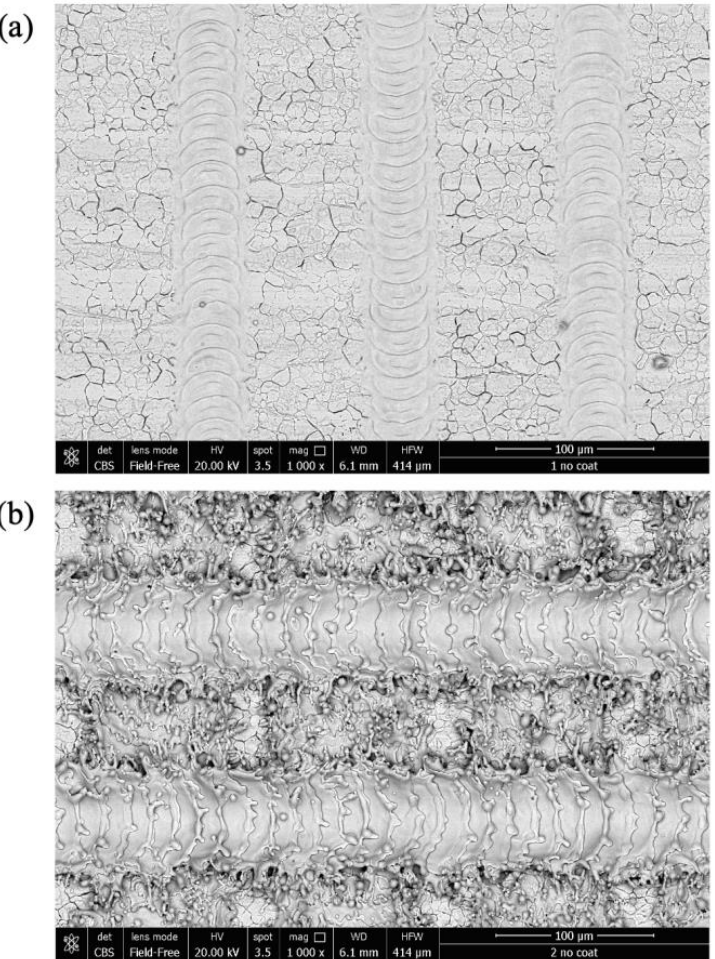
Figure 7. SEM images of laser-textured surfaces without coating obtained with parallel lines scanning strategy: ( a ) 2 W; ( b ) 7 W.